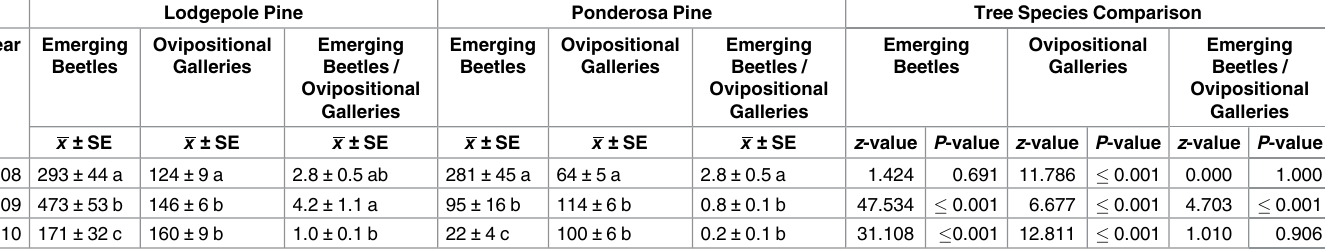
Table 5. Comparison of mountain pine beetle reproductive measuresfrom caged trees between years and tree species using Tukey HSD con- trasts from mixed models. Lodgepole Pine